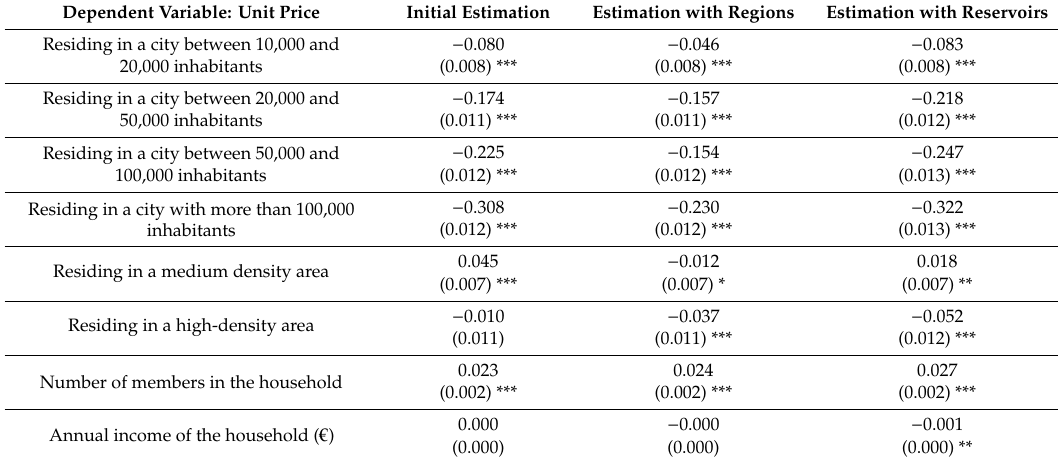
Table 2. Models with price per household as the dependent